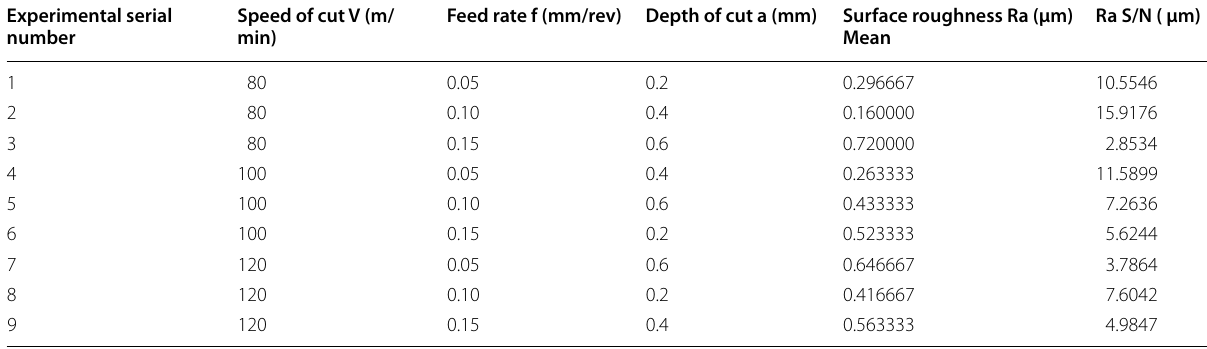
Table 5 Experimental results of surface roughness Ra and S/N ratio Experimental serial